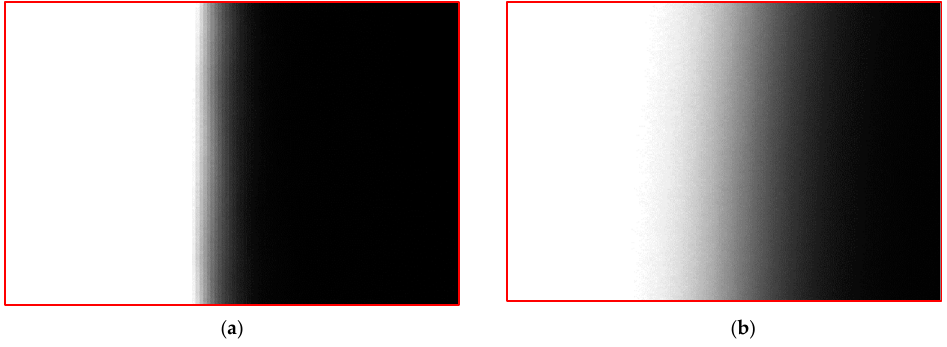
Figure 18. Influence of boundary. ( a ) Clear boundary. ( b ) Fuzzy boundary.